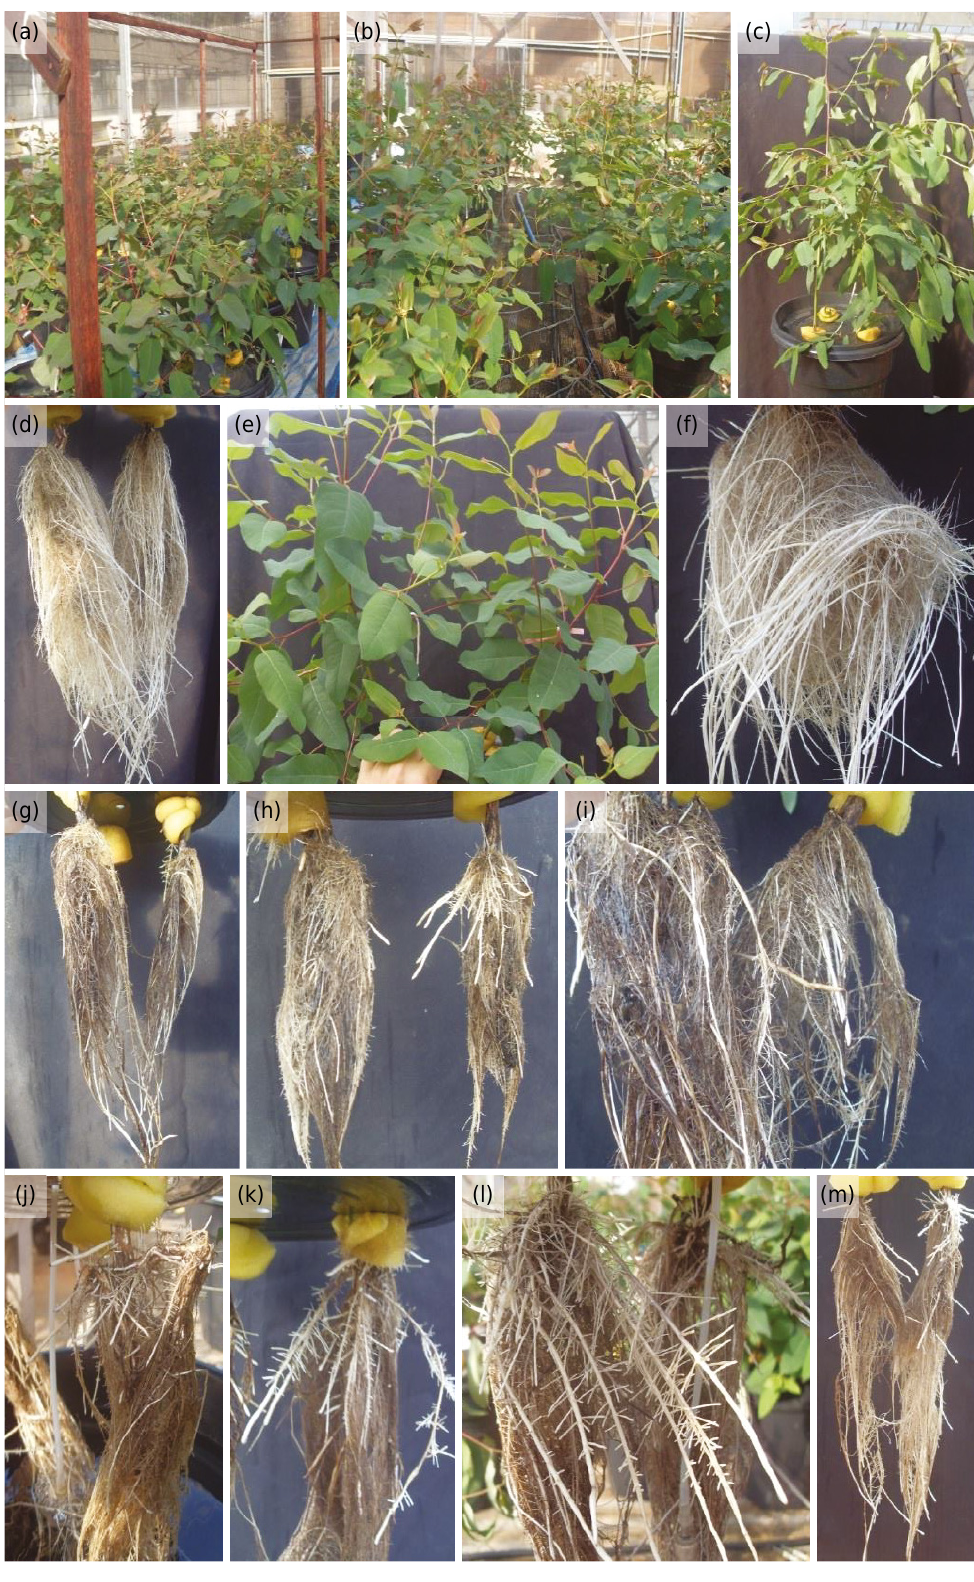
Figure 2. Photographs of the experiment using two Eucalyptus clones with differential tolerance to VRDSD (a, b) subjected to different concentrations of O 2 (8 and 4 mg L -1 ) and Mn (300 and 1.39 mg L -1 ). Each experimental unit consists of two plants. The aboveground part (c) and root (d) of the tolerant clone under normoxia with 300 mg L -1 of Mn. Aboveground part (e) and root (f) of the sensitive clone under normoxia with 1.39 mg L -1 of Mn. Roots of the tolerant clone under hypoxia with 300 mg L -1 of Mn (g, h) and 1.39 mg L -1 of Mn (i) highlight the formation of less adventitious roots. Roots of the sensitive clone under hypoxia with 300 mg L -1 of Mn (j, k) and 1.39 mg L -1 of Mn (l, m) highlight the formation of more adventitious